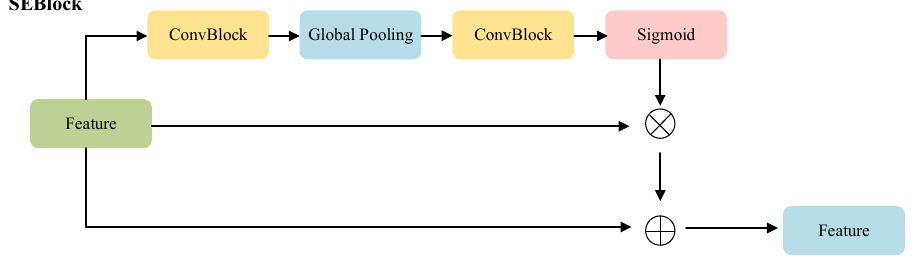
Figure 4. Illustration of the SEBlock.